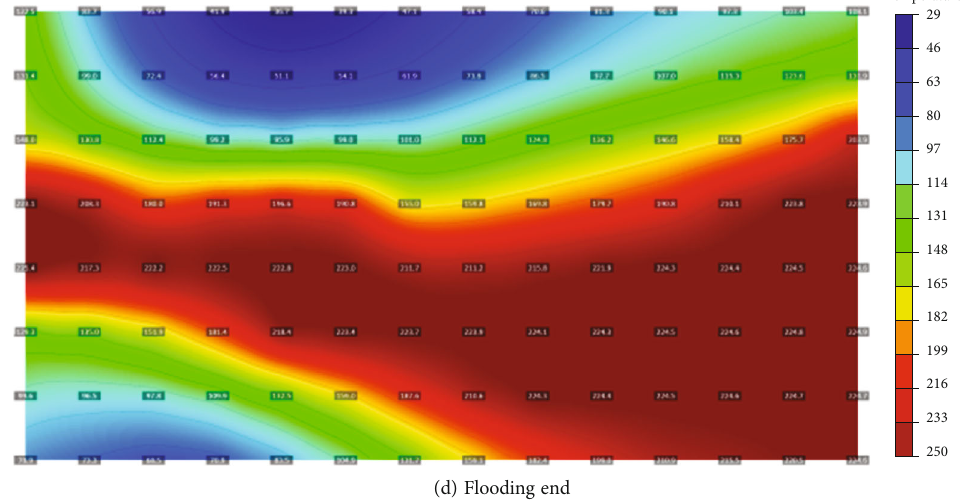
Figure 10: Temperature distribution of vertical-assisted SAGD preheated by conventional